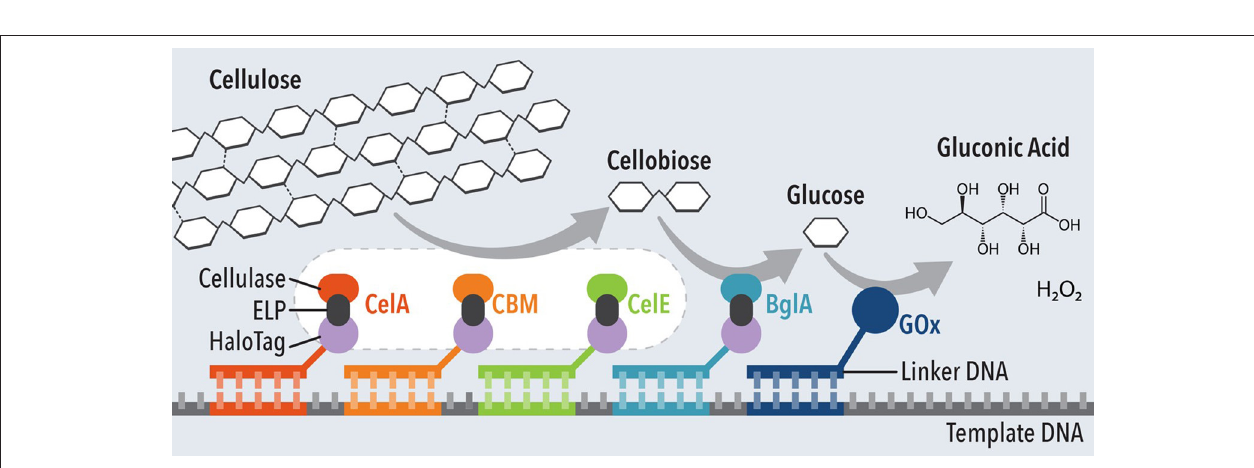
FIGURE 5 | Schematic of five-enzyme cascade system for hydrolysis of cellulose and glucose oxidation. Adapted from Chen et al.